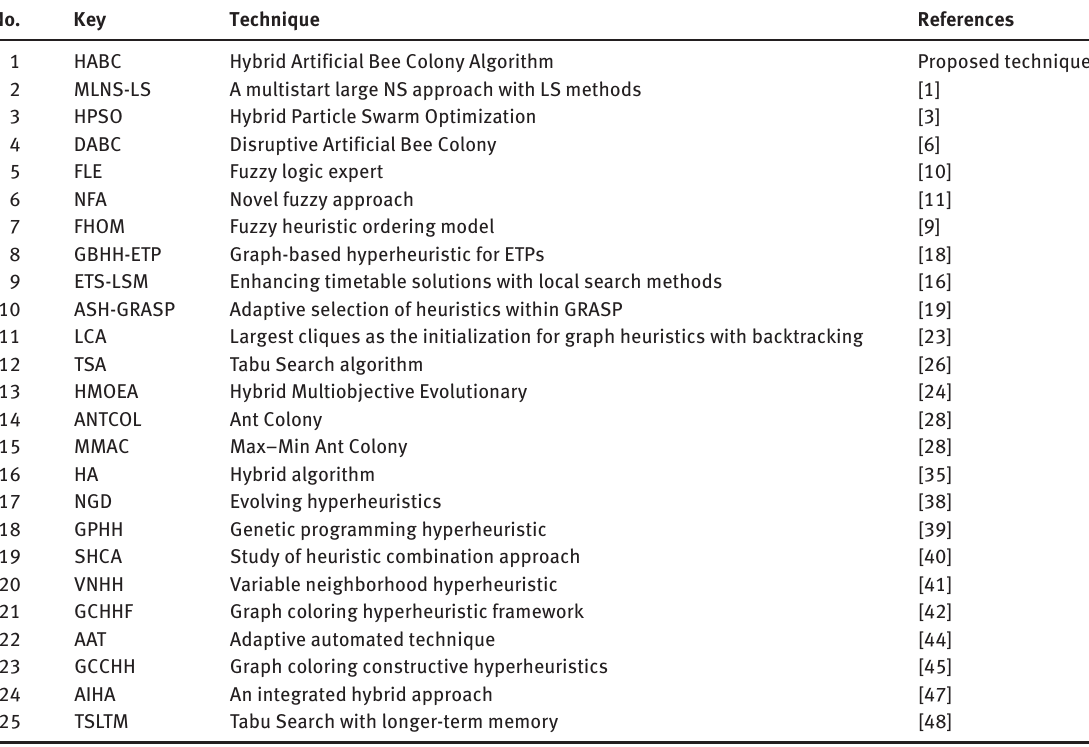
Table 6. Key to Hyperheuristic and Other Heuristic Comparative Techniques. No. Key